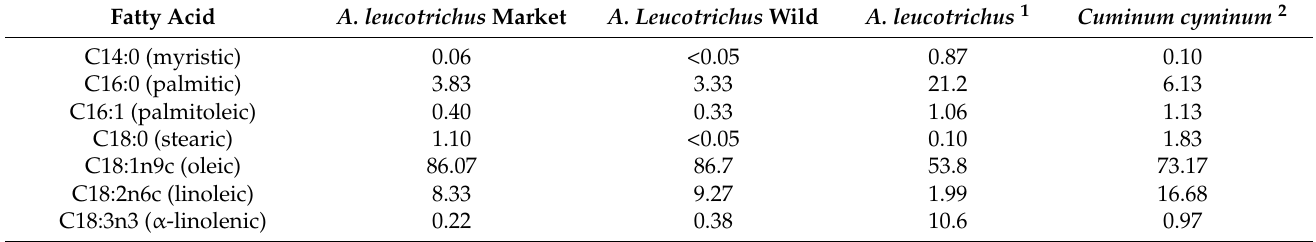
Table 3. Fatty acids (relative percentage) of A. leucotrichus samples compared to literature data for A. leucotrichus and C. cyminum .